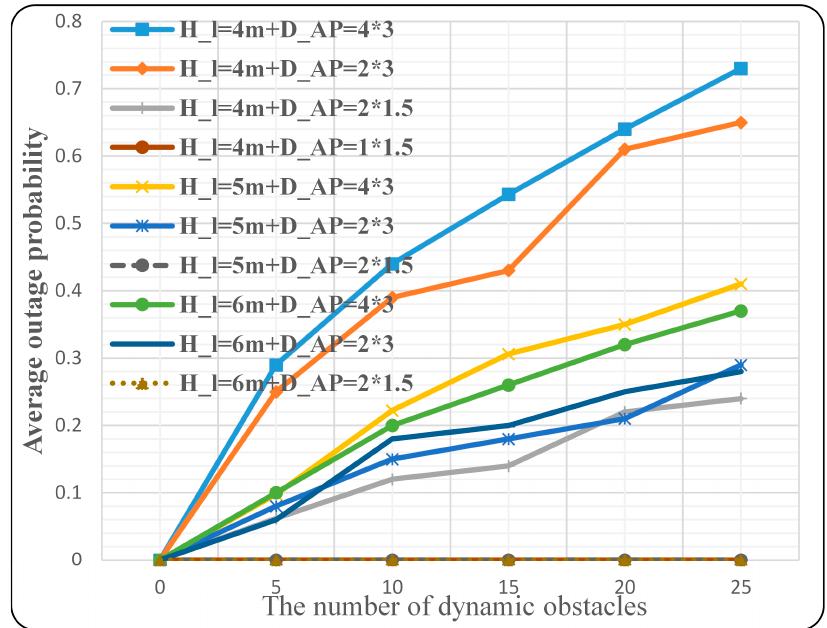
Figure 13. Average outage probability under different AP heights and AP spacings.